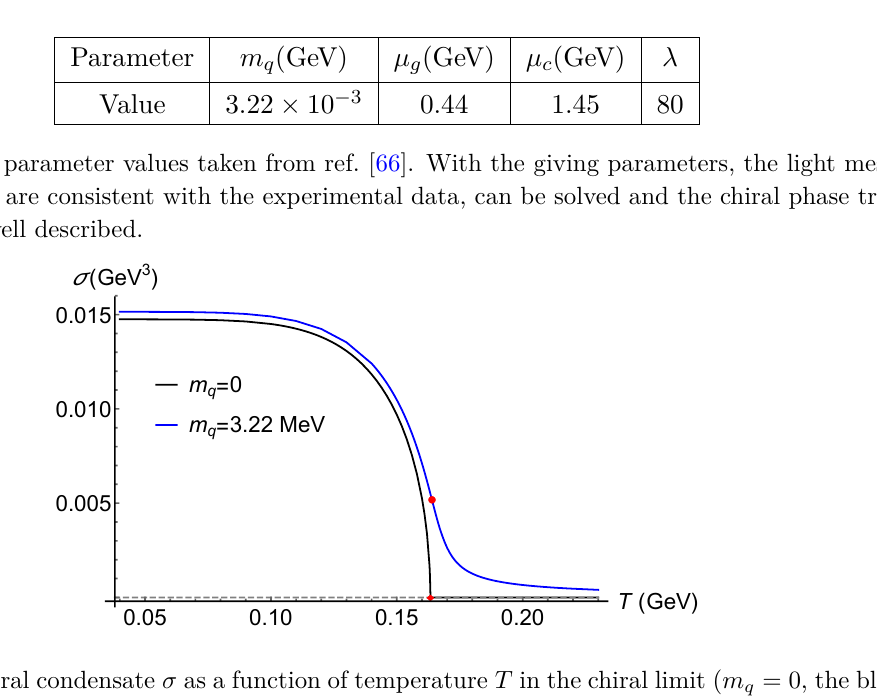
= 0 . Numerically, we get cp